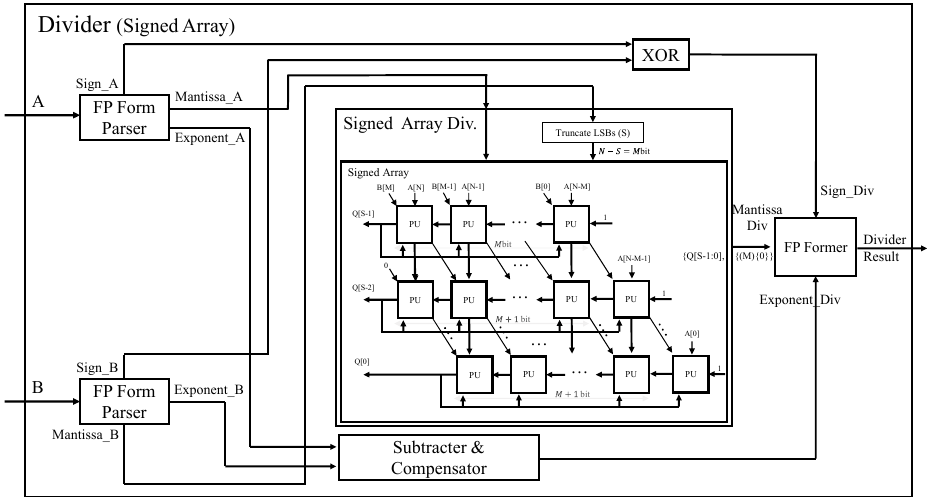
Figure 7. Structure of floating-point division operator using Signed Array.